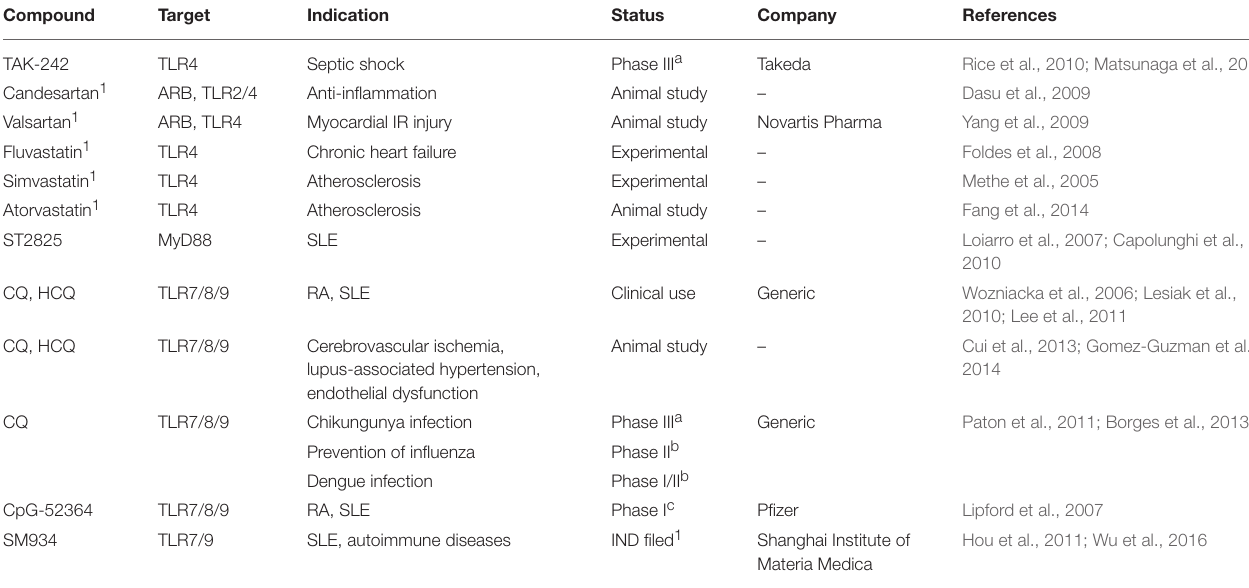
TABLE 3 | The development status of TLR antagonists/inhibitors: class of antibodies. Compound